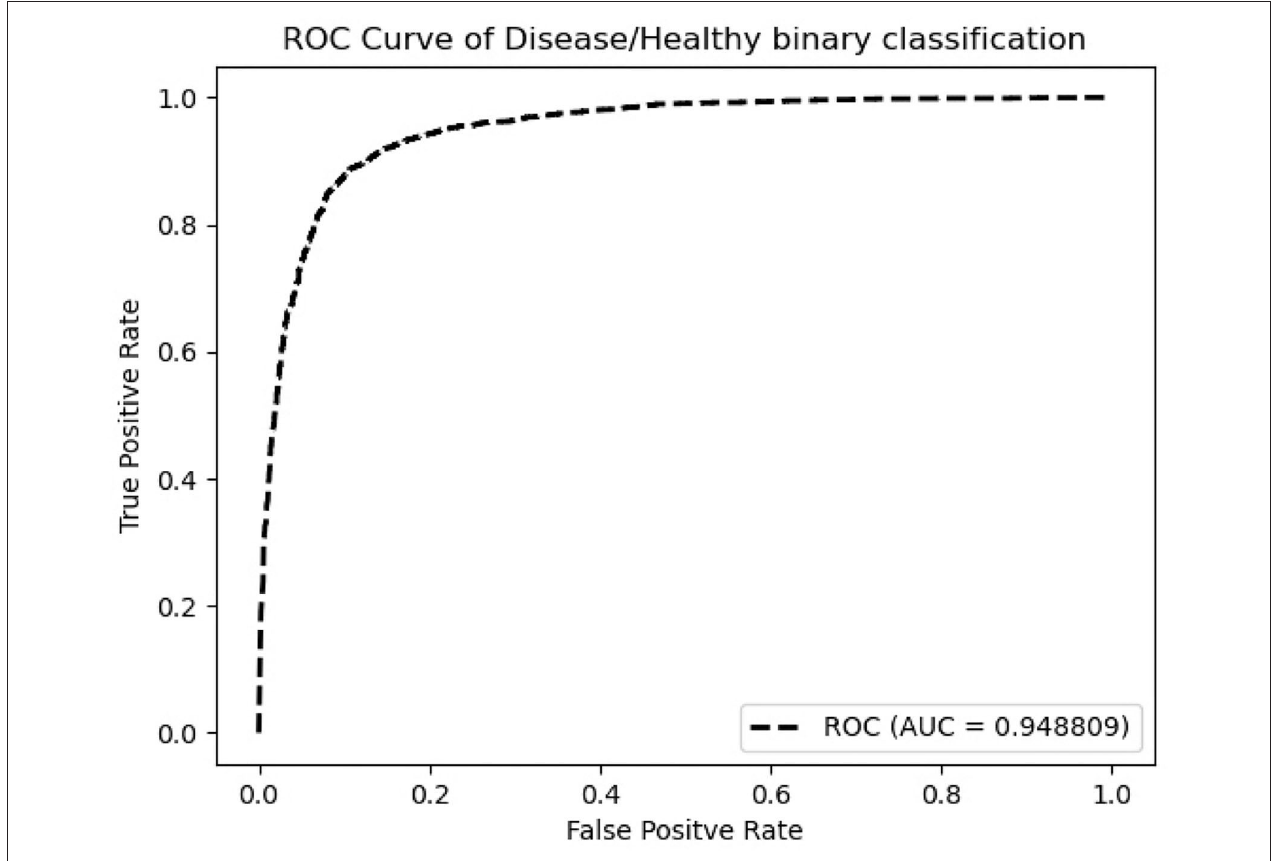
FIGURE 5 | ROC curve of ResNeXt-50 on Dataset